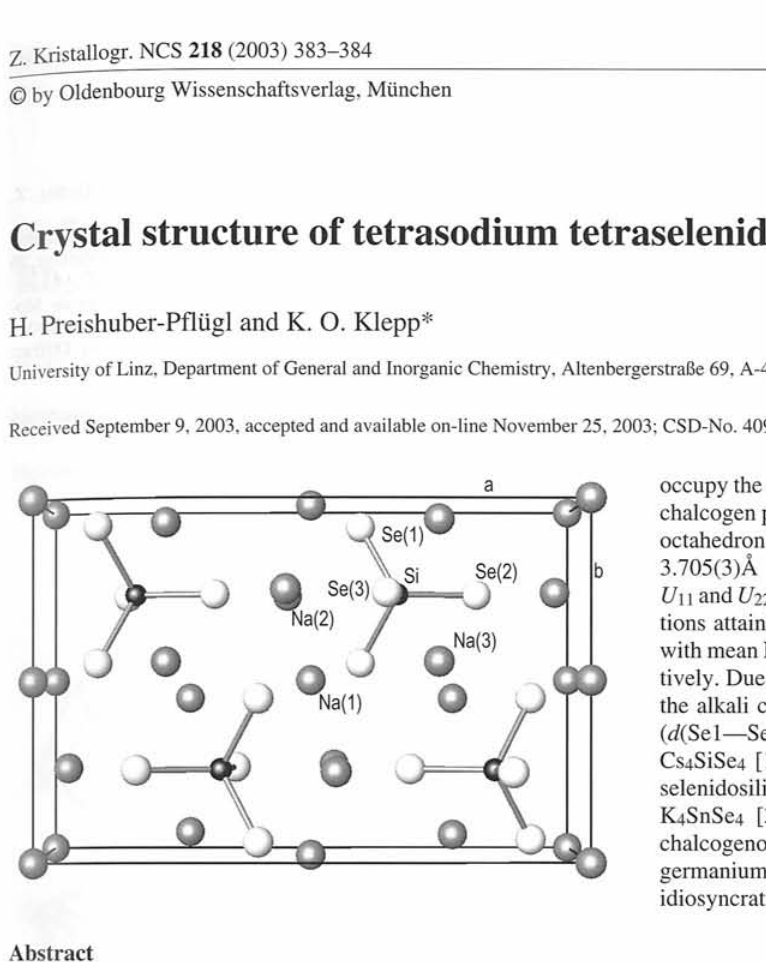
Table 1. Data collection and handling. Crystal: